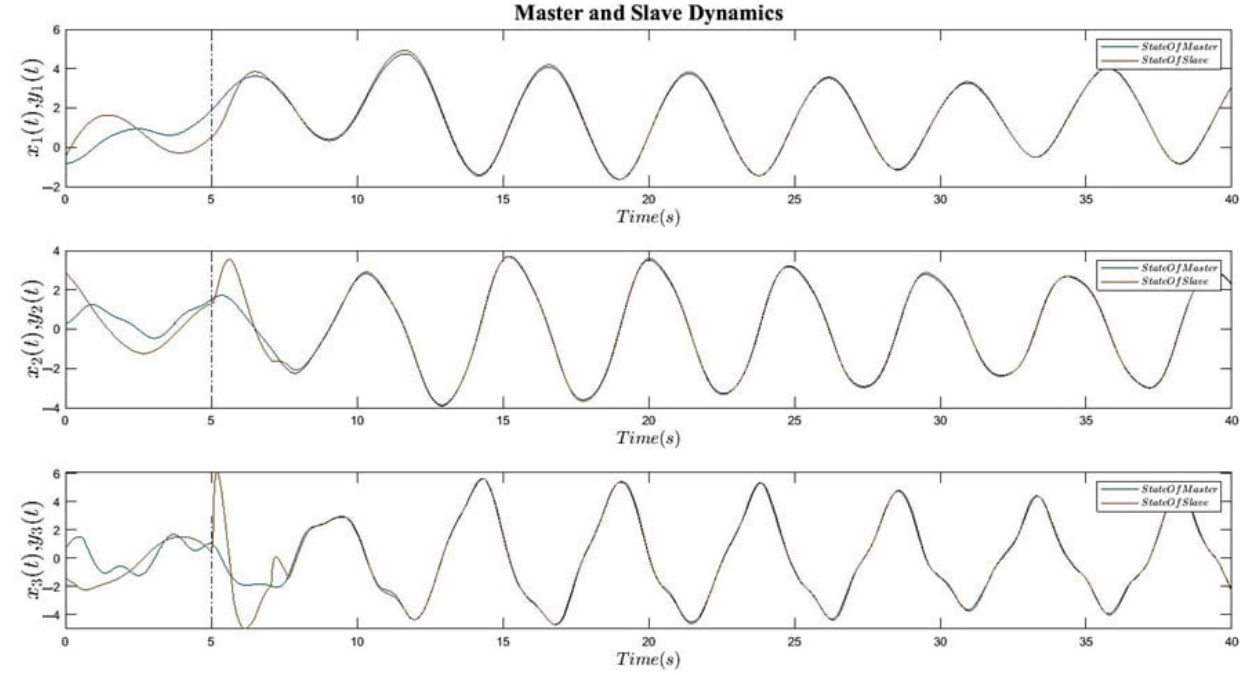
Figure 2. Behavior of master and slave system states without applying the control signal.